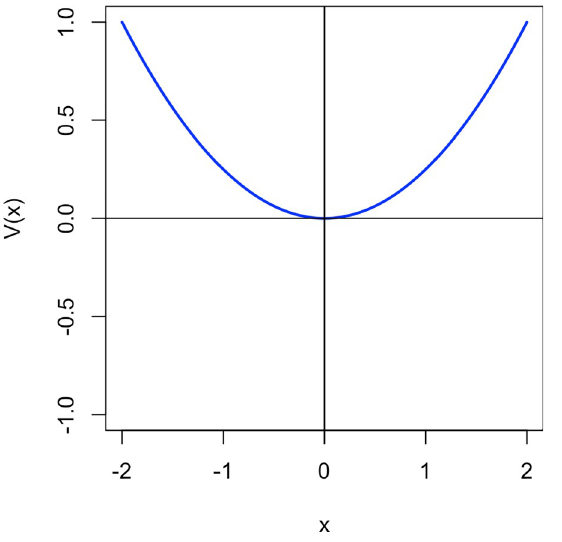
Fig 5. Graph of the potential energy function